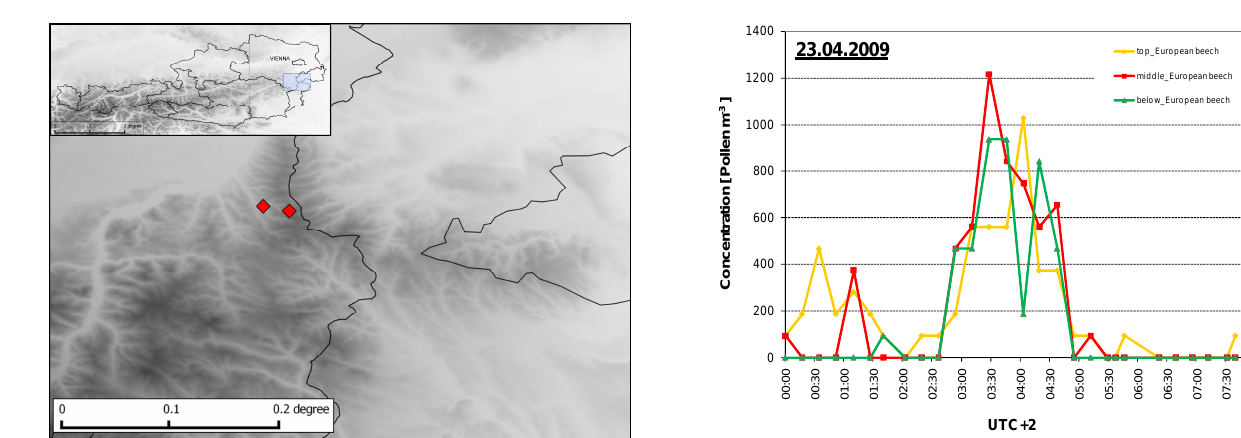
Figure 1. Location of the meteorological towers (red triangles) in the Rosalia mountains (Lehrforst Rosalia) and schematic loca- tion of the Lehrforst in Austria. Scale is in degrees (0.2 ◦ is ap- prox. 15.5km).